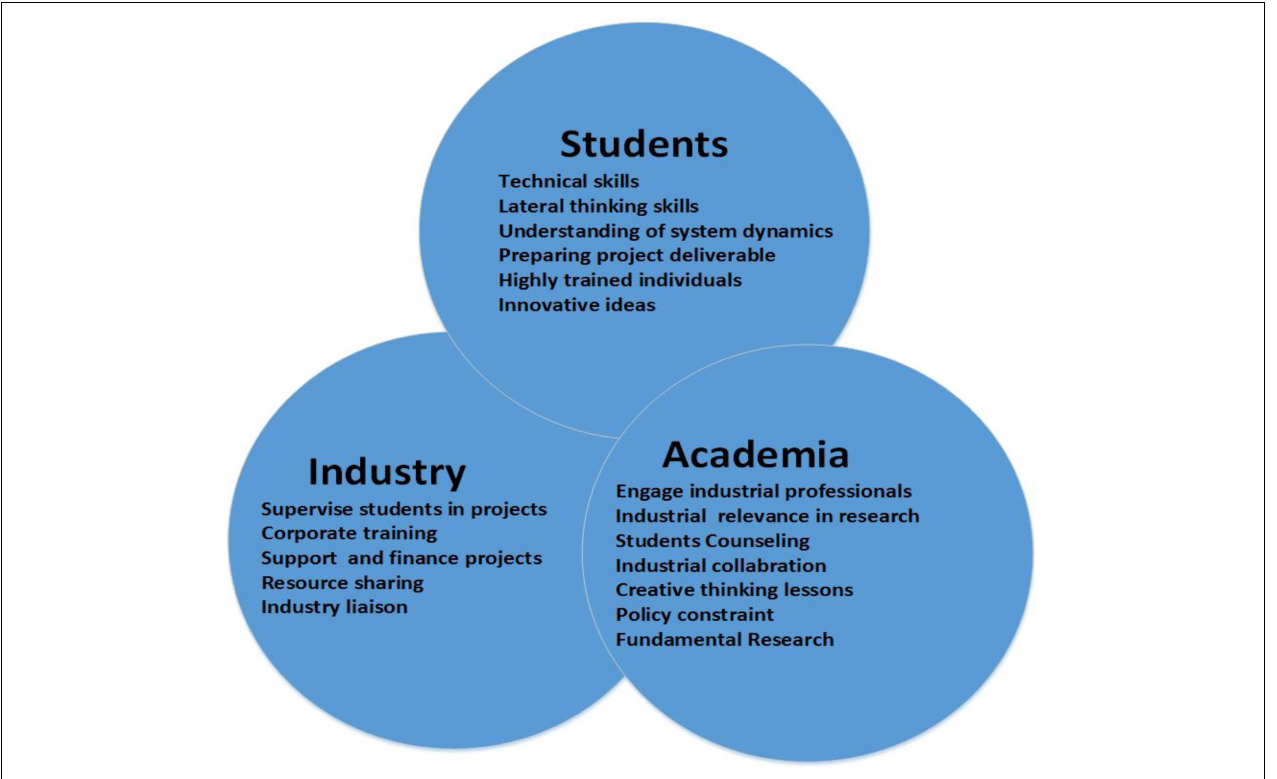
FIGURE 1 | Role of students, industry, and academia (Iyer,